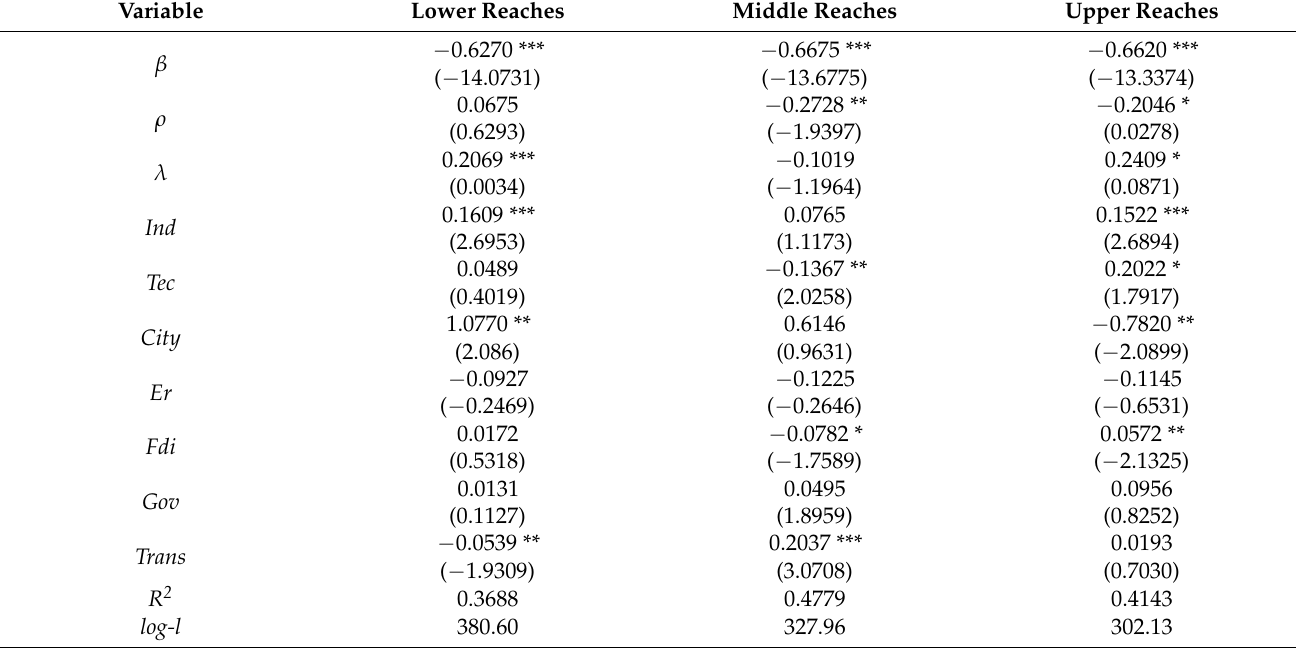
Table 9. Analysis results of heterogeneity of the EWP based on regional